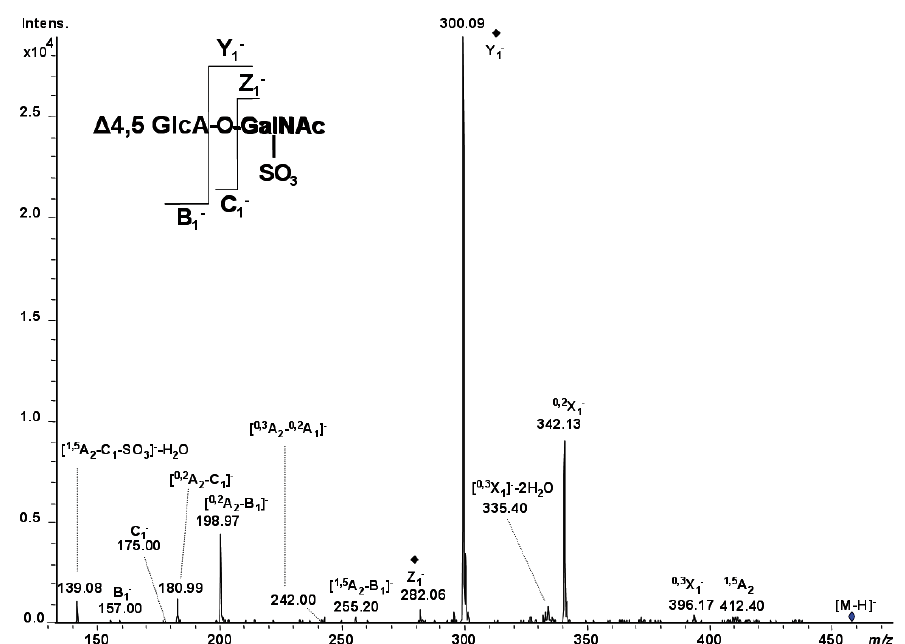
Figure 3. Fully automated chip (-) nanoESI HCT CID MS 2 of the singly deprotonated ion at m/z 458.11 assigned according to mass calculation to monosulfated standard CS disaccharide having the composition [4,5- Δ -GlcA-GalNAc] (6S). Fragmentation amplitude within 0.40-0.80 V. Diagnostic ions for GalNAc monosulfation are marked by ( ♦